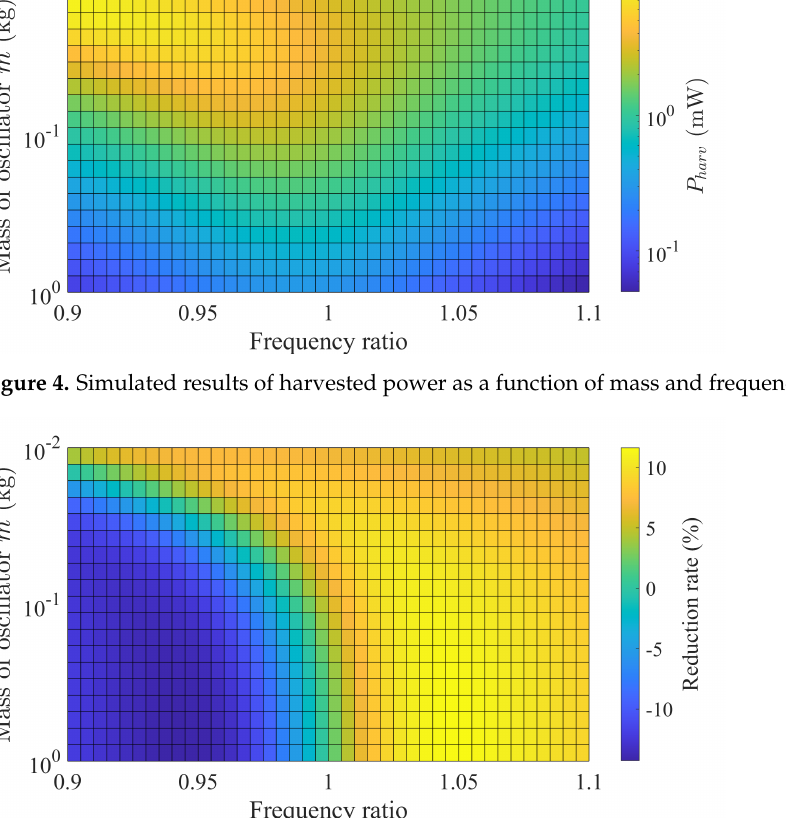
Figure 5. Simulated results of the torque ripple reduction rate as a function of the mass and fre- quency